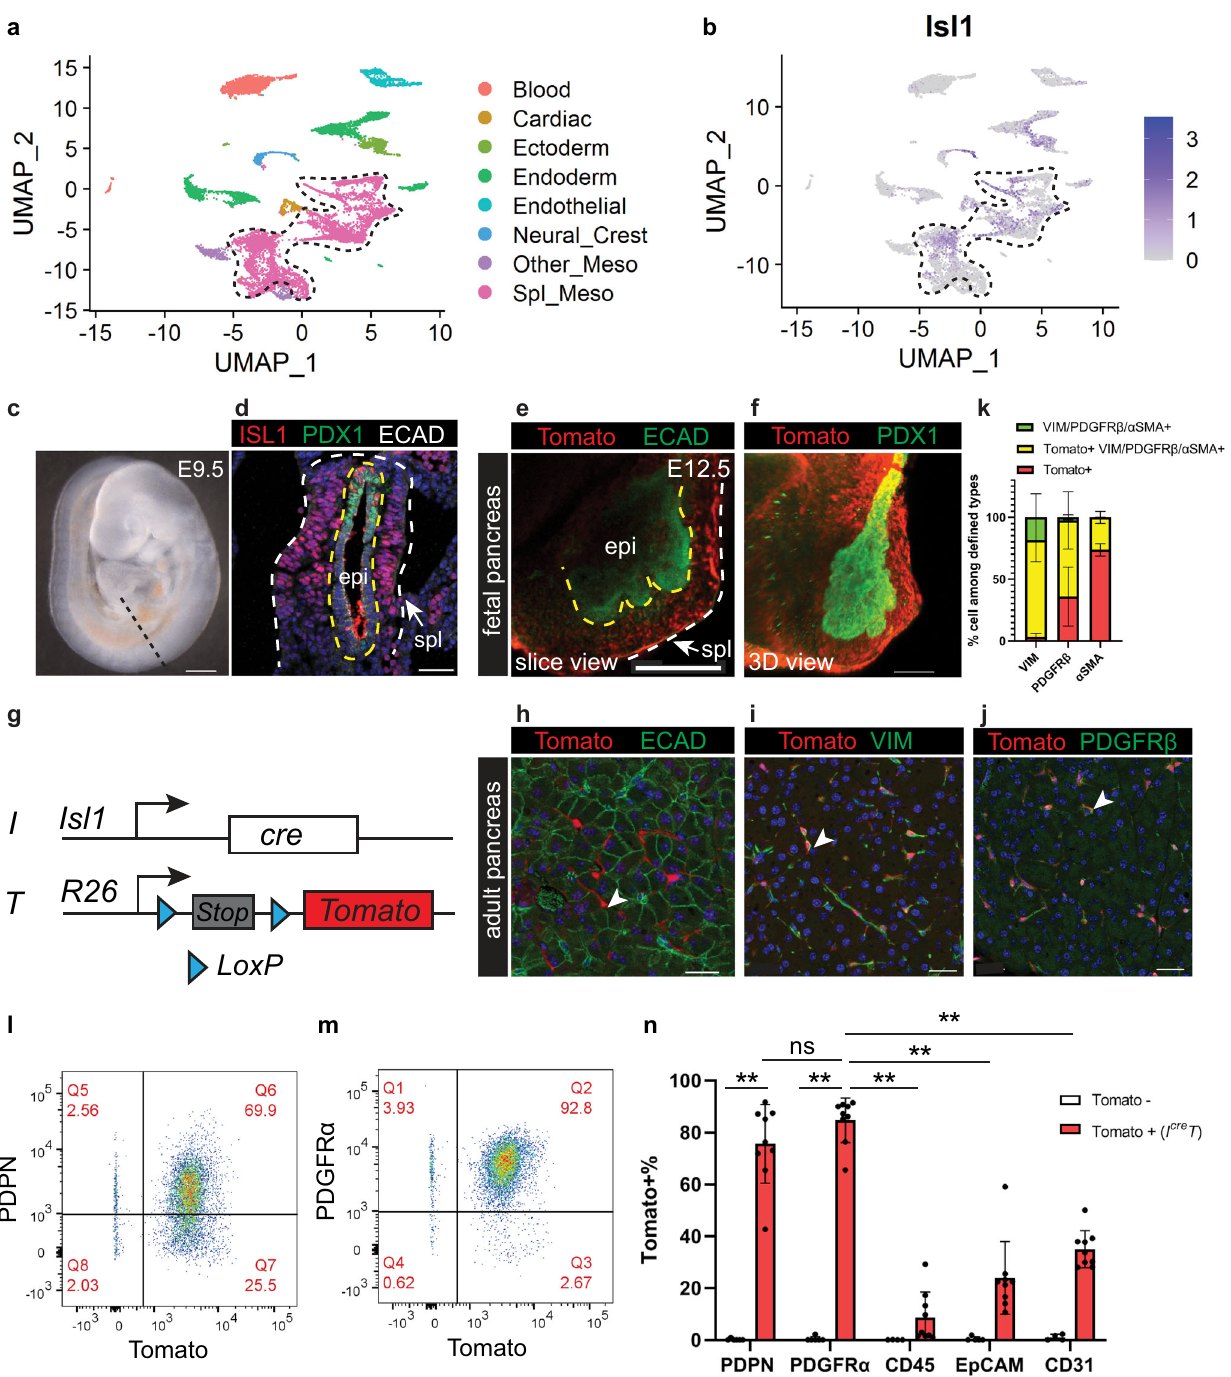
Fig. 2 | Tissue-resident fi broblasts in the adult pancreas are derived from ISL1 expressing splanchnic mesenchyme during fetal development. a Clustering analysis of single-cell transcriptome pro fi les of E9.5 mouse foregut cells. b Isl1 expression projected on clusters in ( a ). Dashed lines delineate the splanchnic mesenchymecluster. c LateralviewofanE9.5mouseembryo.Dashedlineindicates a transverse section at the pancreatic level. d Immunostaining on mouse foregut indicated in ( c ). n =3 embryos. e , f Whole mount immunostaining of a dissected pancreas. Yellow dashed lines delineate the epithelium, while the yellow and the white lines delineate the splanchnic mesenchyme. n =3 pancreata. g Schematic of